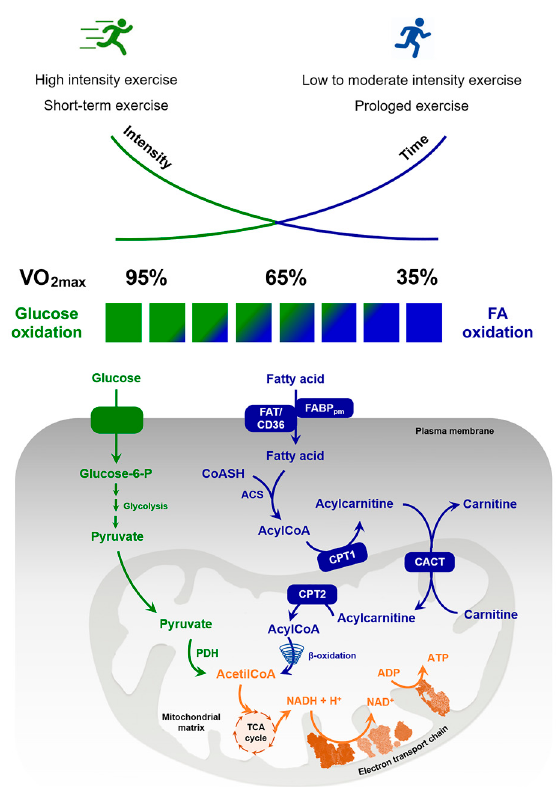
Figure 2. Integration of carbohydrate and lipid metabolism in skeletal muscle cells during exercise. Fat and carbohydrate are important fuels for aerobic exercise and there can be reciprocal shifts depending on the exercise intensity and duration. During prolonged exercise at a low to moderate intensity (35% of VO 2max ), most of the energy requirements for skeletal muscle can be met from predominantly FA oxidation, with a very small contribution from glucose oxidation. Increases in exercise intensity produce a progressive shift in energy contribution from fat towards carbohydrate, until it reaches 95% of VO 2max , when glucose becomes the main energy source of fuel for skeletal muscle contraction. The figure also shows the regulation involving many sites of control (transport of FFAs into the muscle cell by FA binding protein of the plasma membrane (FABPpm) and FAT / CD36, and into the mitochondria via carnitine palmitoyl transferase (CPT1 / CPT2) and the role of carnitine-acylcarnitine translocase (CACT)). When glycolytic flux is increased, as during high-intensity aerobic exercise, the enhanced pyruvate production leads to acetyl-CoA excess and ATP resynthesis at high-energy requirements. At lower exercise intensities or during prolonged exercise, a lower glycolytic rate decreases the supply of glycolysis-derived acetyl-CoA and the reduced sequestration of carnitine enables increased FA import through CPT1 and carnitine shuttle system, favoring utilization of β -oxidation-derived acetyl-CoA in the TCA cycle and ultimately FA oxidation.